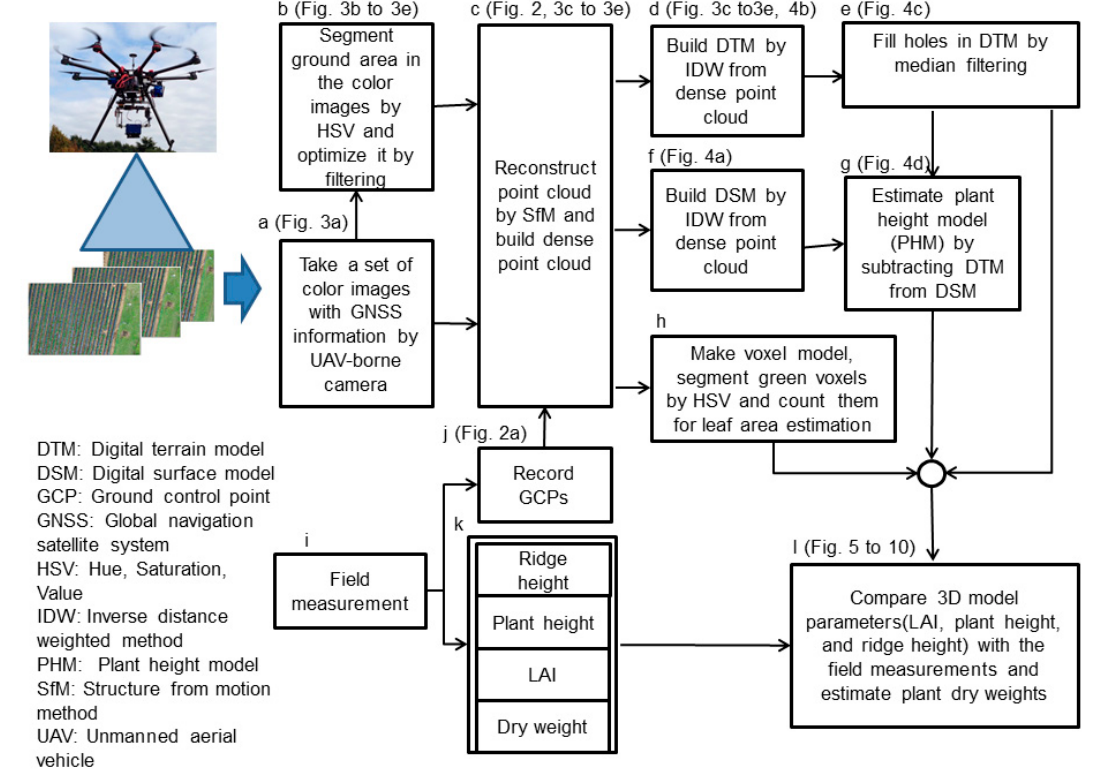
Figure 1. Workflow chart of sweet potato plant modeling from images taken by UAV.